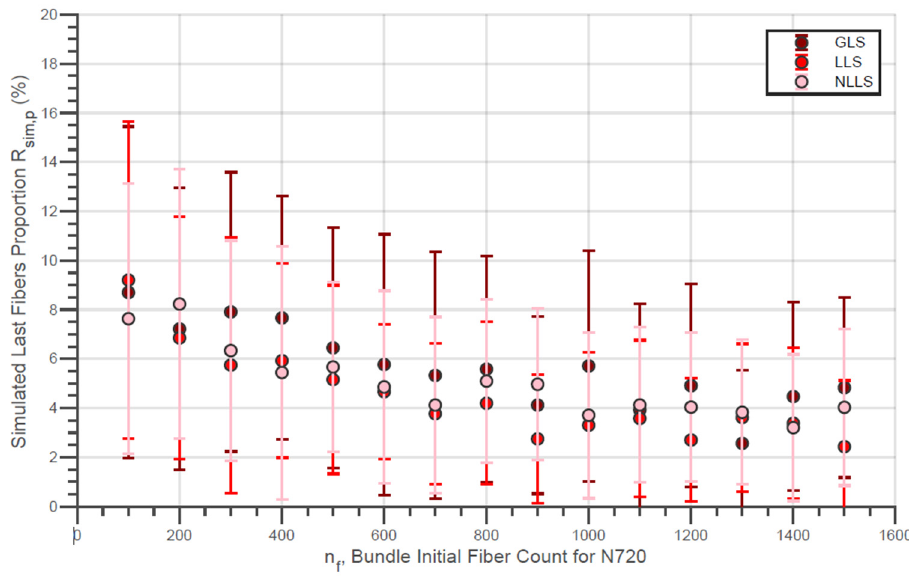
Figure 17. Simulated Last Fiber Proportion for Different Fiber Amounts for Virtual N720 Fiber Bundles.